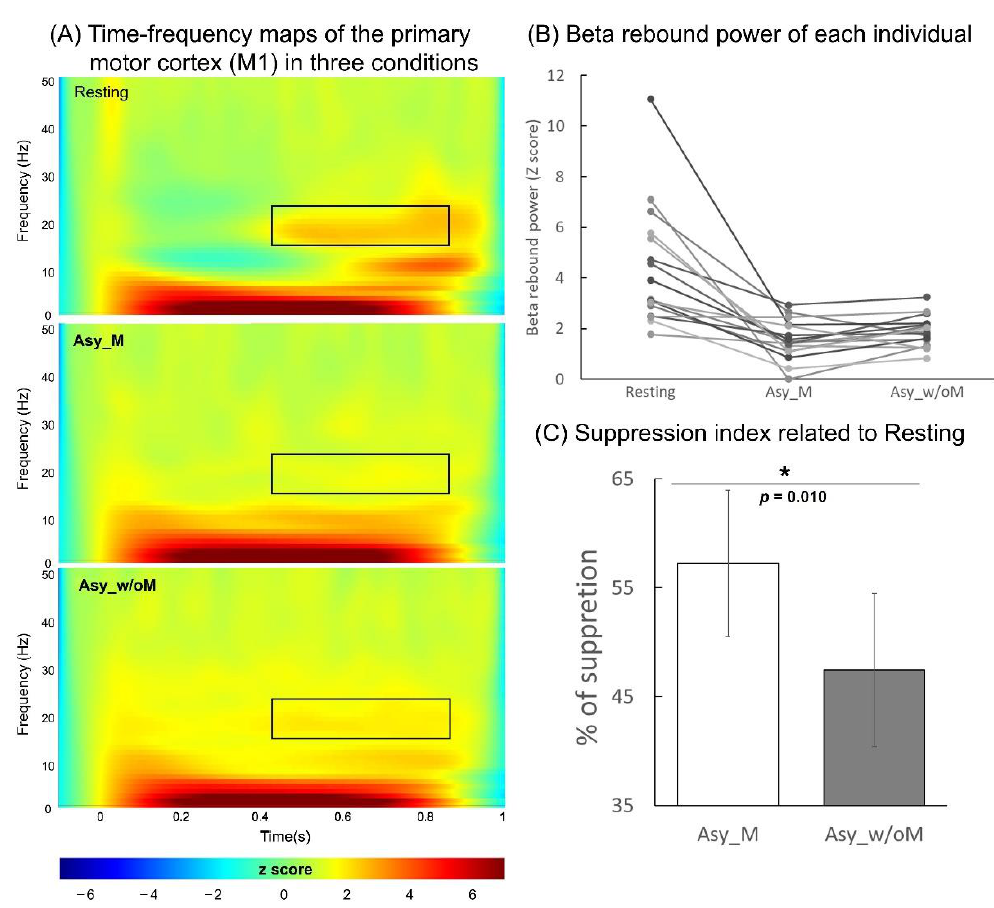
Figure 3. ( A ) Grand-averaged time-frequency maps of electricity-induced beta rebound oscillation (black rectangles) of the right primary motor cortex (M1) in the resting, asynchronous bimanual movement with mirror visual feedback (Asy_M), and asynchronous bimanual movement without mirror visual feedback (Asy_w/oM) conditions. ( B ) The M1 beta rebound strength from each individual in the three conditions. ( C ) The suppression index refers to the extent of beta power suppression in two manipulated conditions with respect to the resting condition. The beta rebound oscillations were suppressed more under Asy_M than under